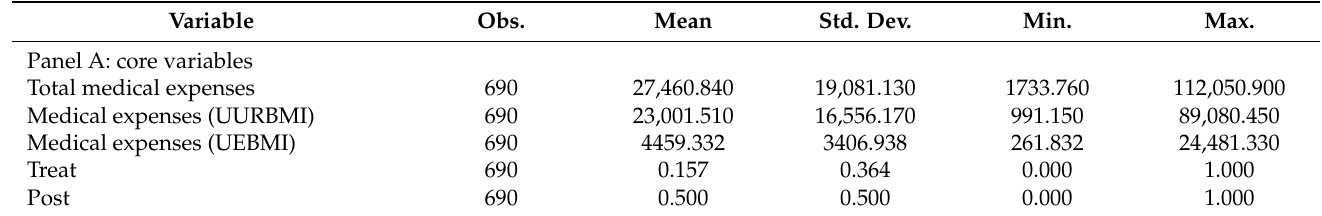
Table 1. Summary